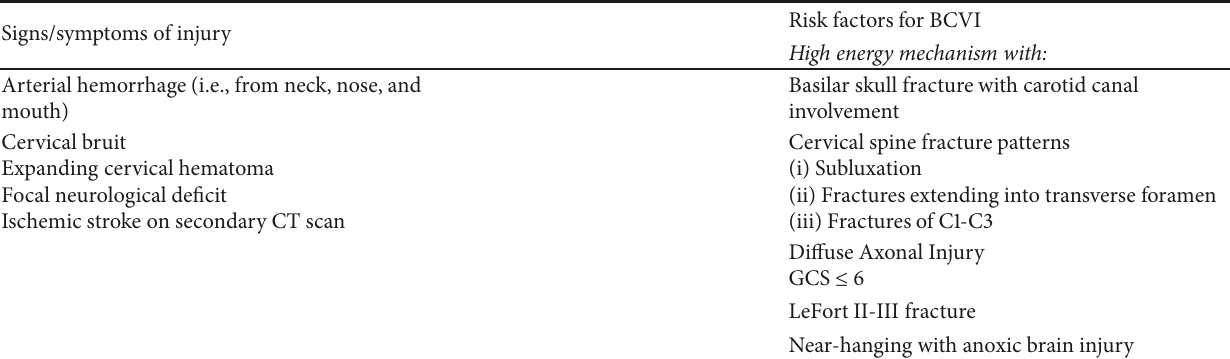
Table 2: Screening criteria for BCVI from